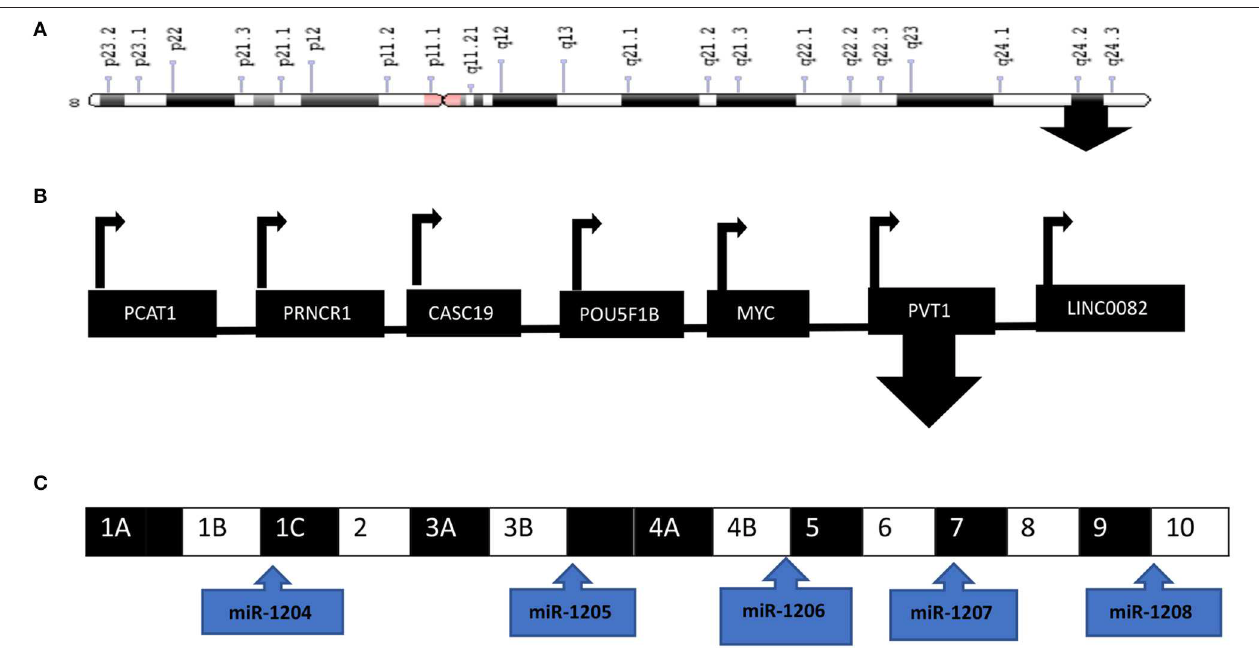
FIGURE 2 | PVT1 is located at the 8q24 chromosomal region downstream of MYC. (A) Ideogram of chromosome 8 with the arrow located at 8q24. (B) PVT1 is one of the genes located at the 8q24 chromosomal region (C) PVT1 exons and the encoded miRNAs are depicted in the diagram. Illustration created with information from